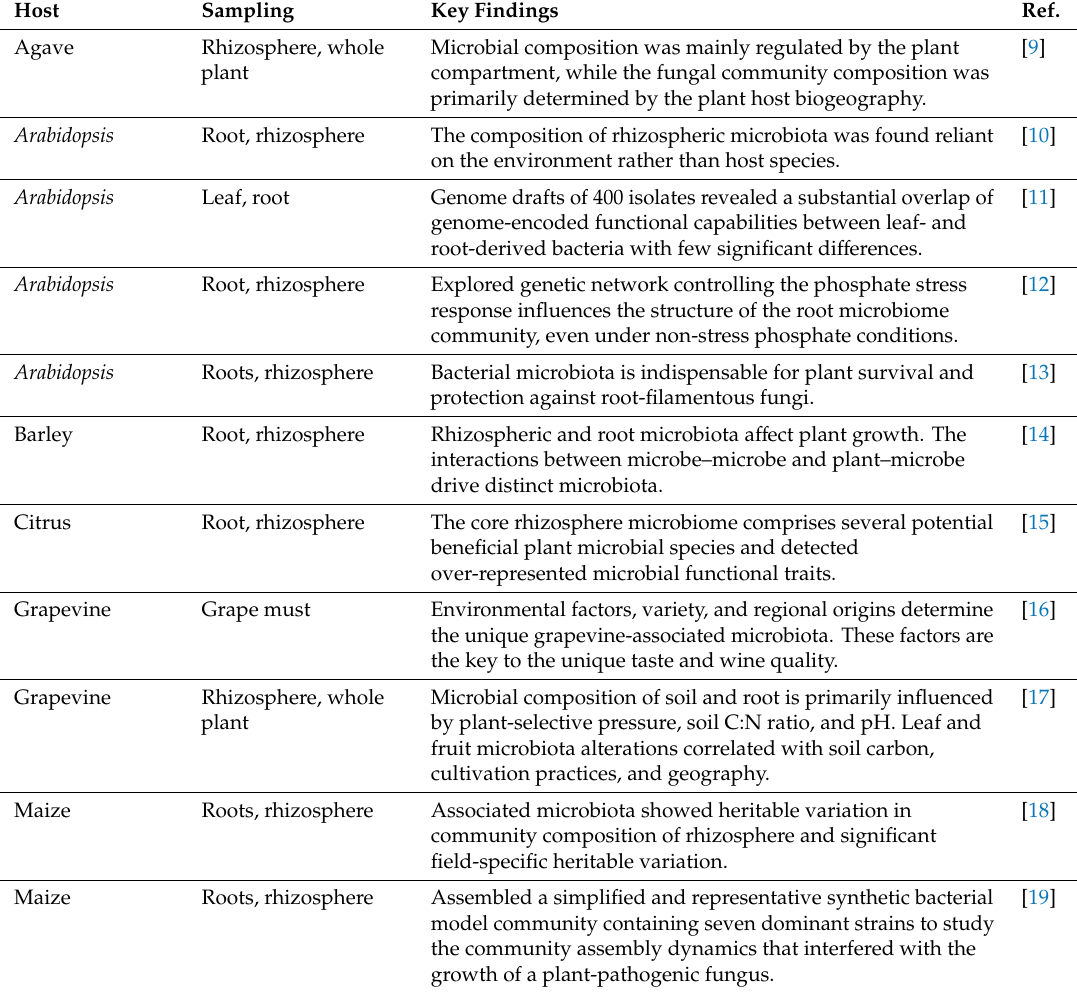
Table 1. Metagenomic-based studies of plant microbiota are summarized. Sampling Key Findings